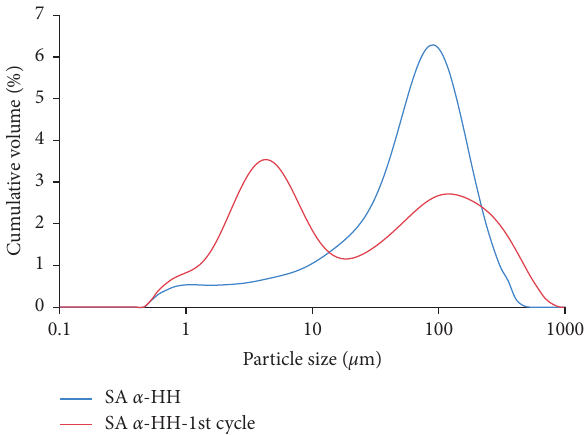
Figure 9: Particle size distribution of pure SA α -HH and SA α -HH after the first cycle.